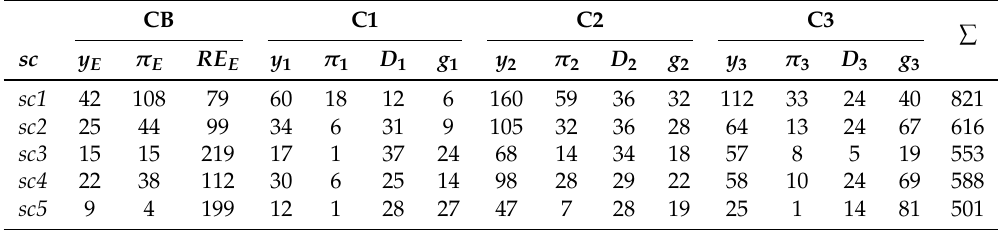
Table 11. Detailed objective function values, robustness experiment ‘exp2’.